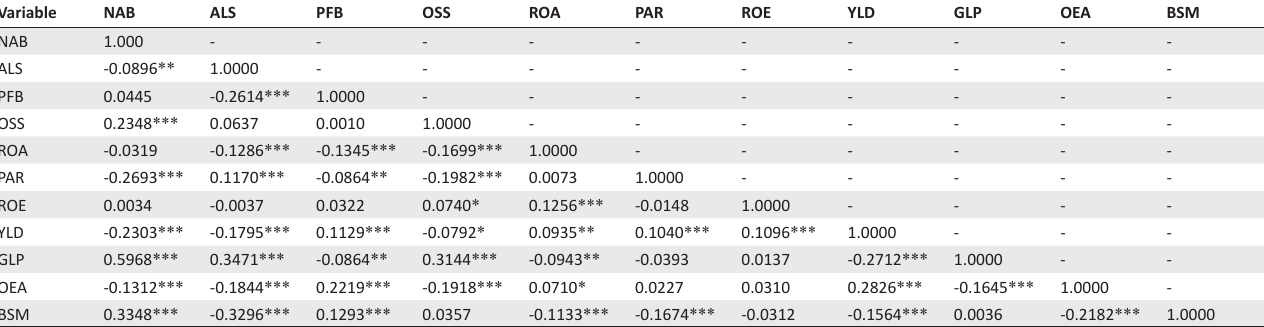
TABLE 3: Correlation analysis results for microfinance institutions outreach. Variable